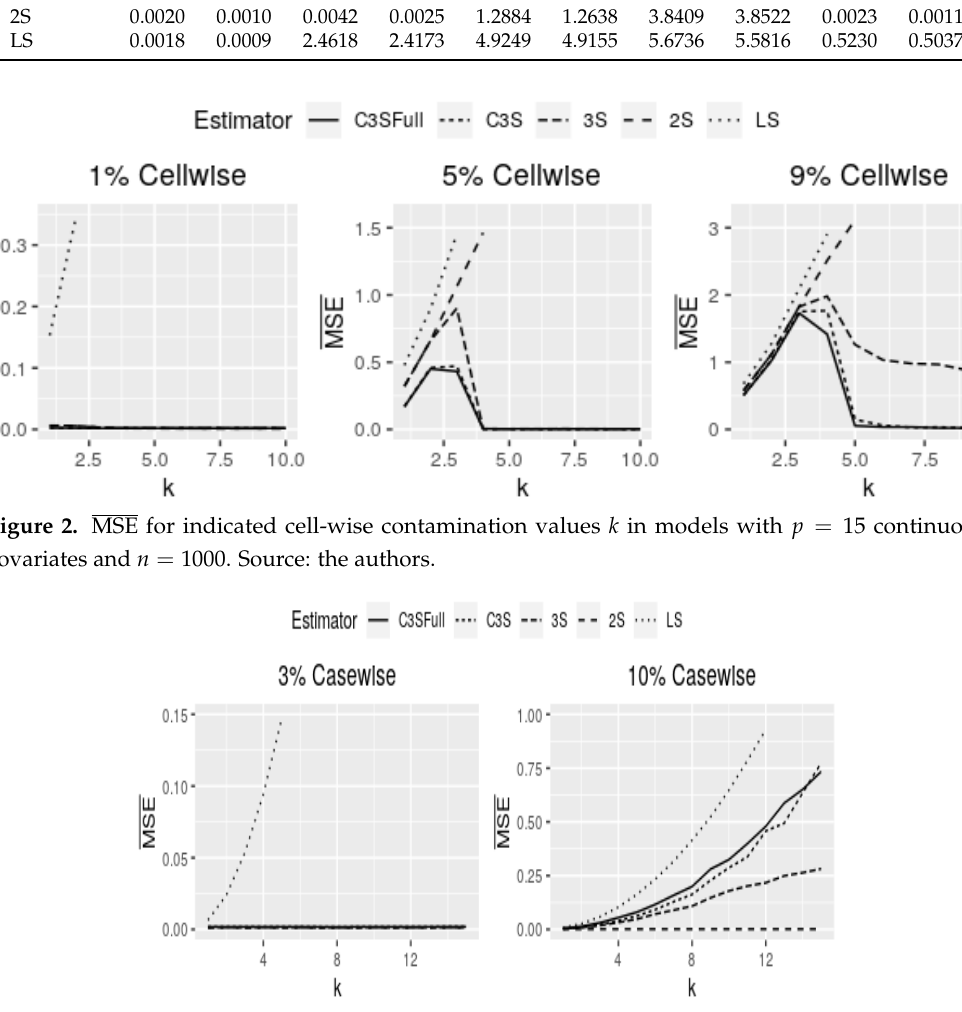
Figure 3. MSE for indicated case-wise contamination values k , in models with p = 15 continuous covariates and n = 1000. Source: the